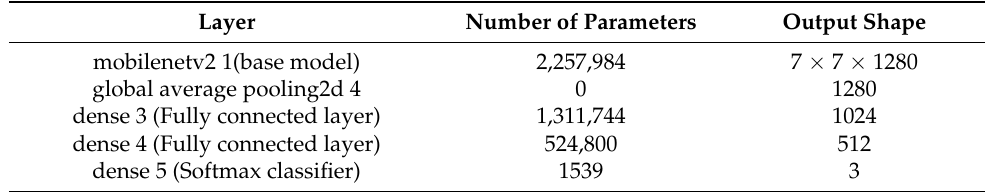
Table 1. Architecture details of the implemented model.